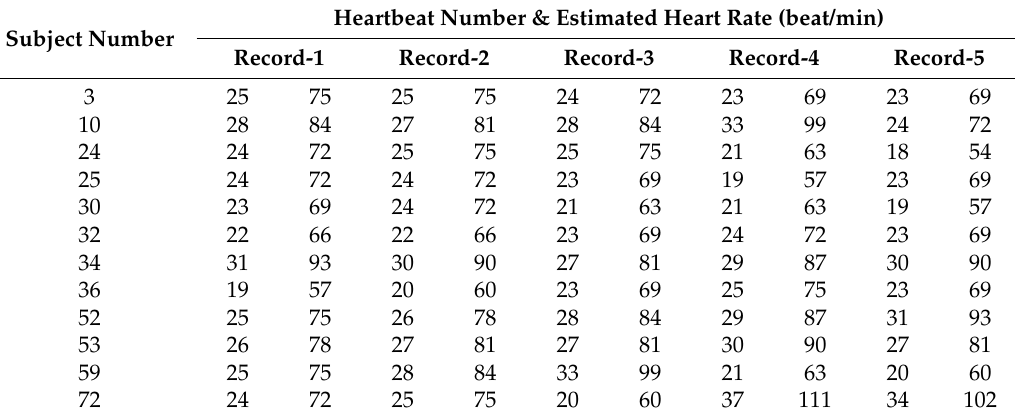
Table 2. Heart number & estimated heart rate (HR) of used signals for experiments.